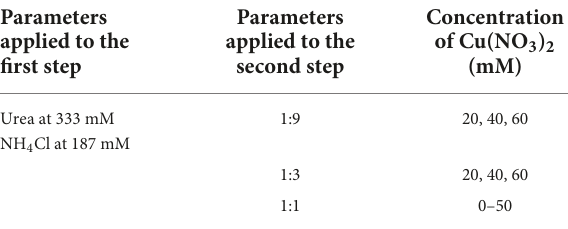
TABLE 2 Scheme applied to the test tube experiments. Parameters applied to the